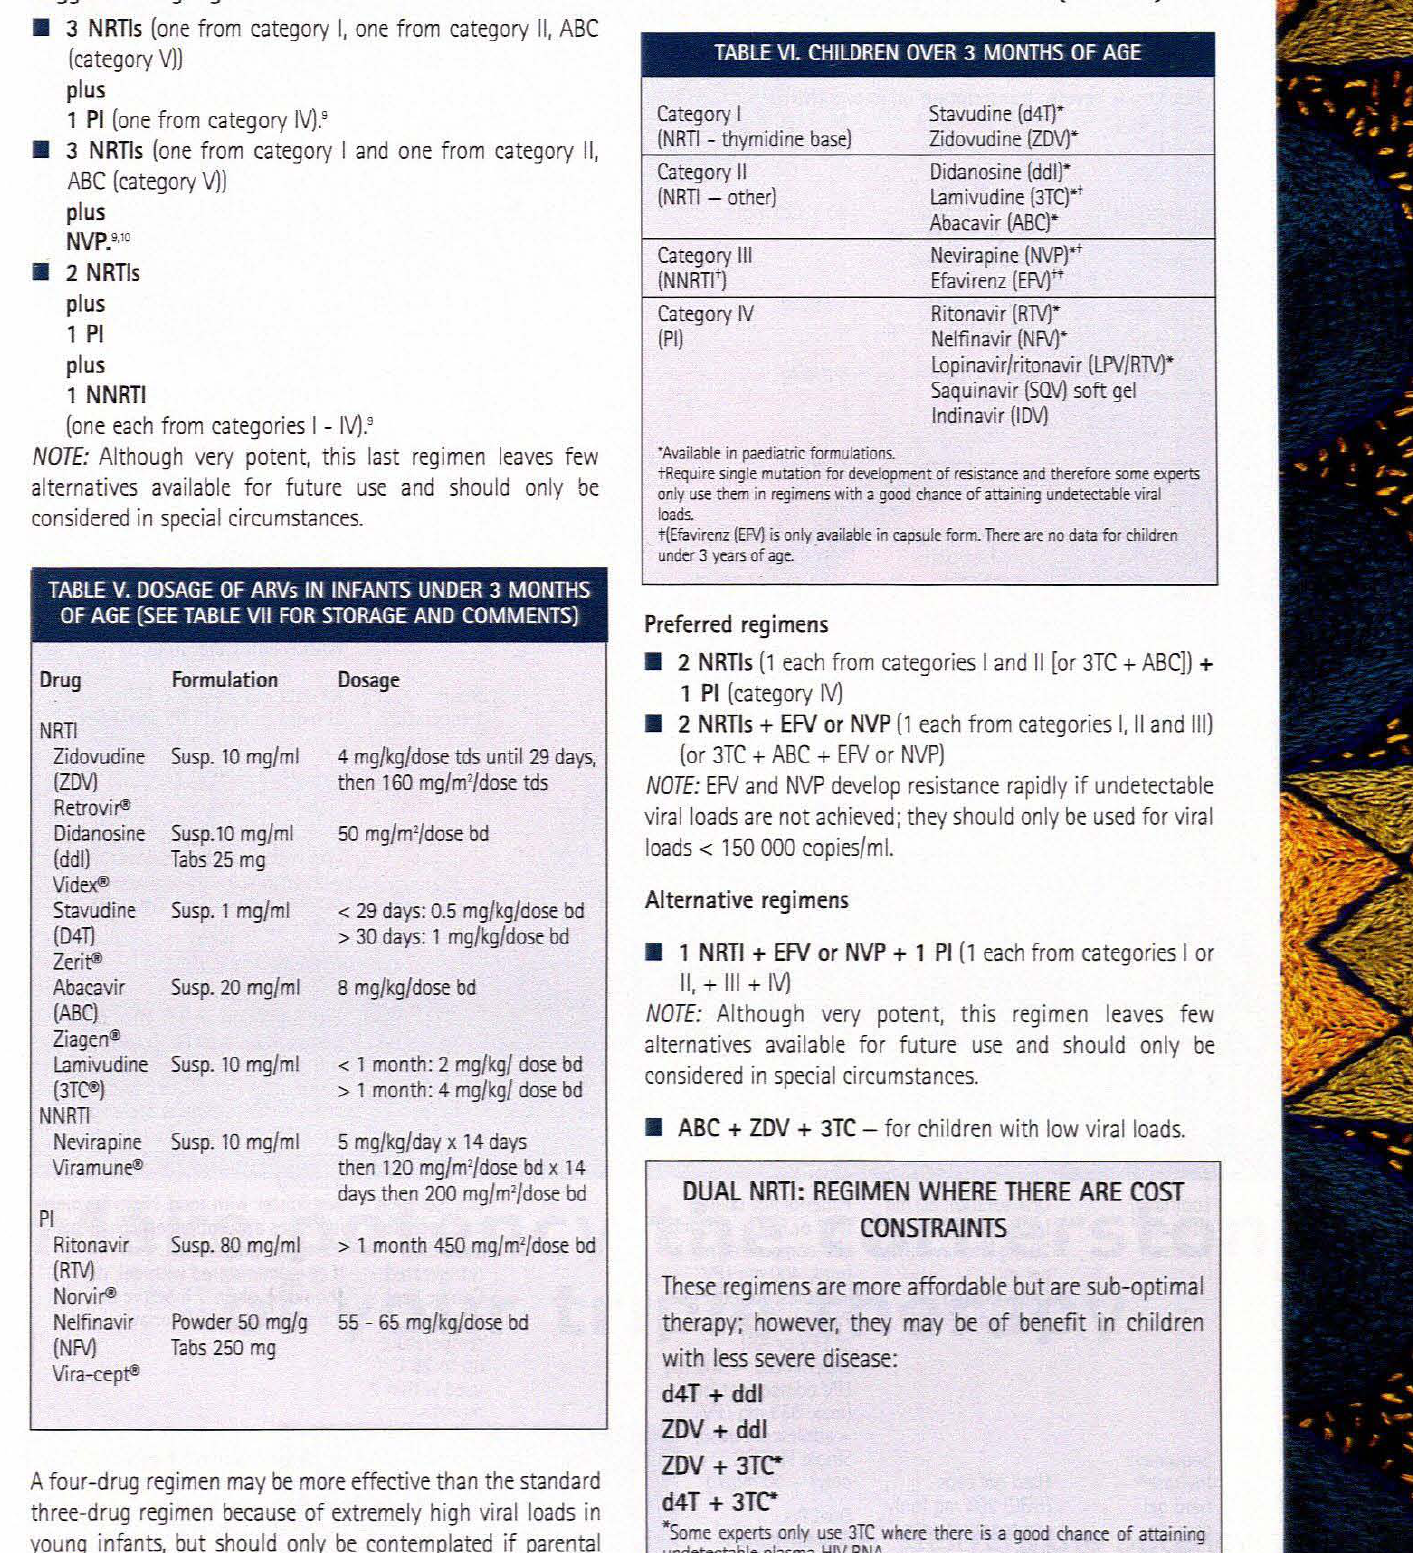
TABLE VI. CHILDREN OVER 3 MONTHS OF